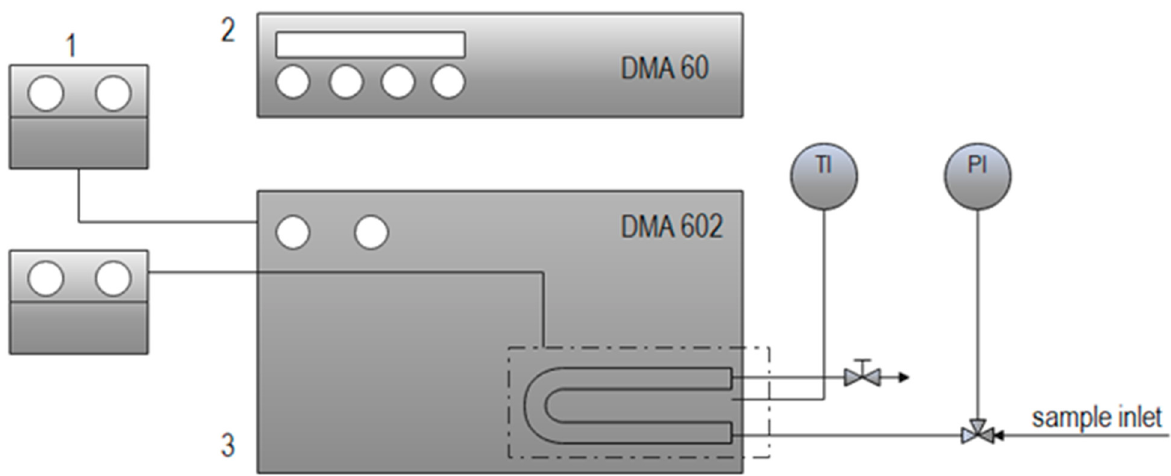
Figure 1. A scheme of a high-pressure cell with a vibrating U-tube for determination of density of gas–2-propanol systems; 1—thermostat, 2—electric control unit, 3—cell with a U-tube, TI—temperature indicator, PI—pressure indicator.